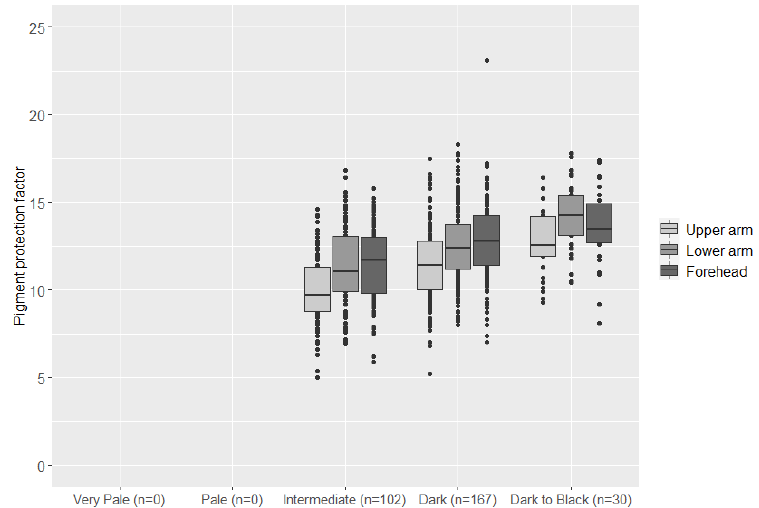
Figure 4. Boxplots showing the skin color category predicted with the HIrisPlex-S prediction model and the pigmentation protection factor on the upper arm, lower arm, and forehead.